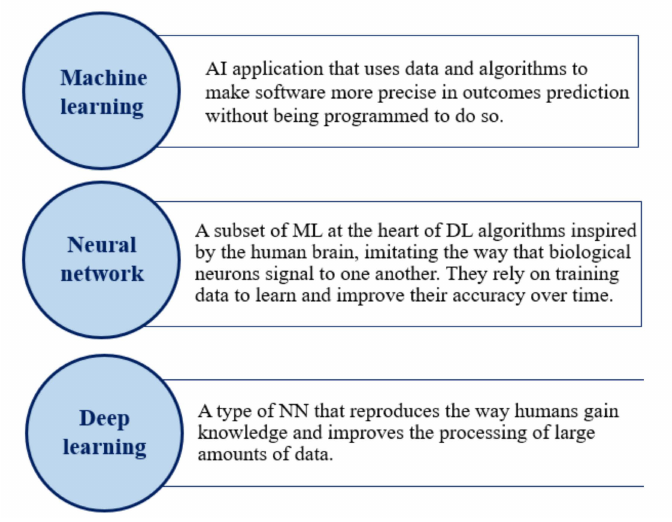
Figure 3. ML versus NN versus DL (source: adapted from